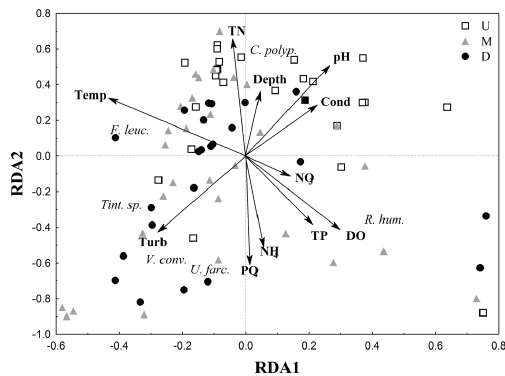
Figure 10. Ordination diagram for the two first axes of the Redundancy Analysis, according to the environmental variables and ciliate abundance along the three stretches of the Paraná River in the dry period. Cond = conductivity; D = depth; DO = dissolved oxygen; Down = downstream; M = middle; NO3 = nitrate; NH4 = ammonium; PO4 = orthophosphate; Temp = temperature; TN = total nitrogen; TP = total phosphorus; Turb = turbidity; Up =